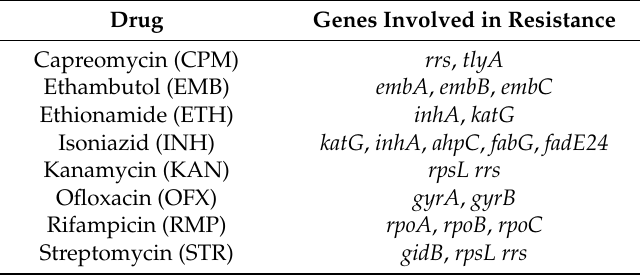
Table 2. Anti-tuberculosis drug resistance-associated genes a .